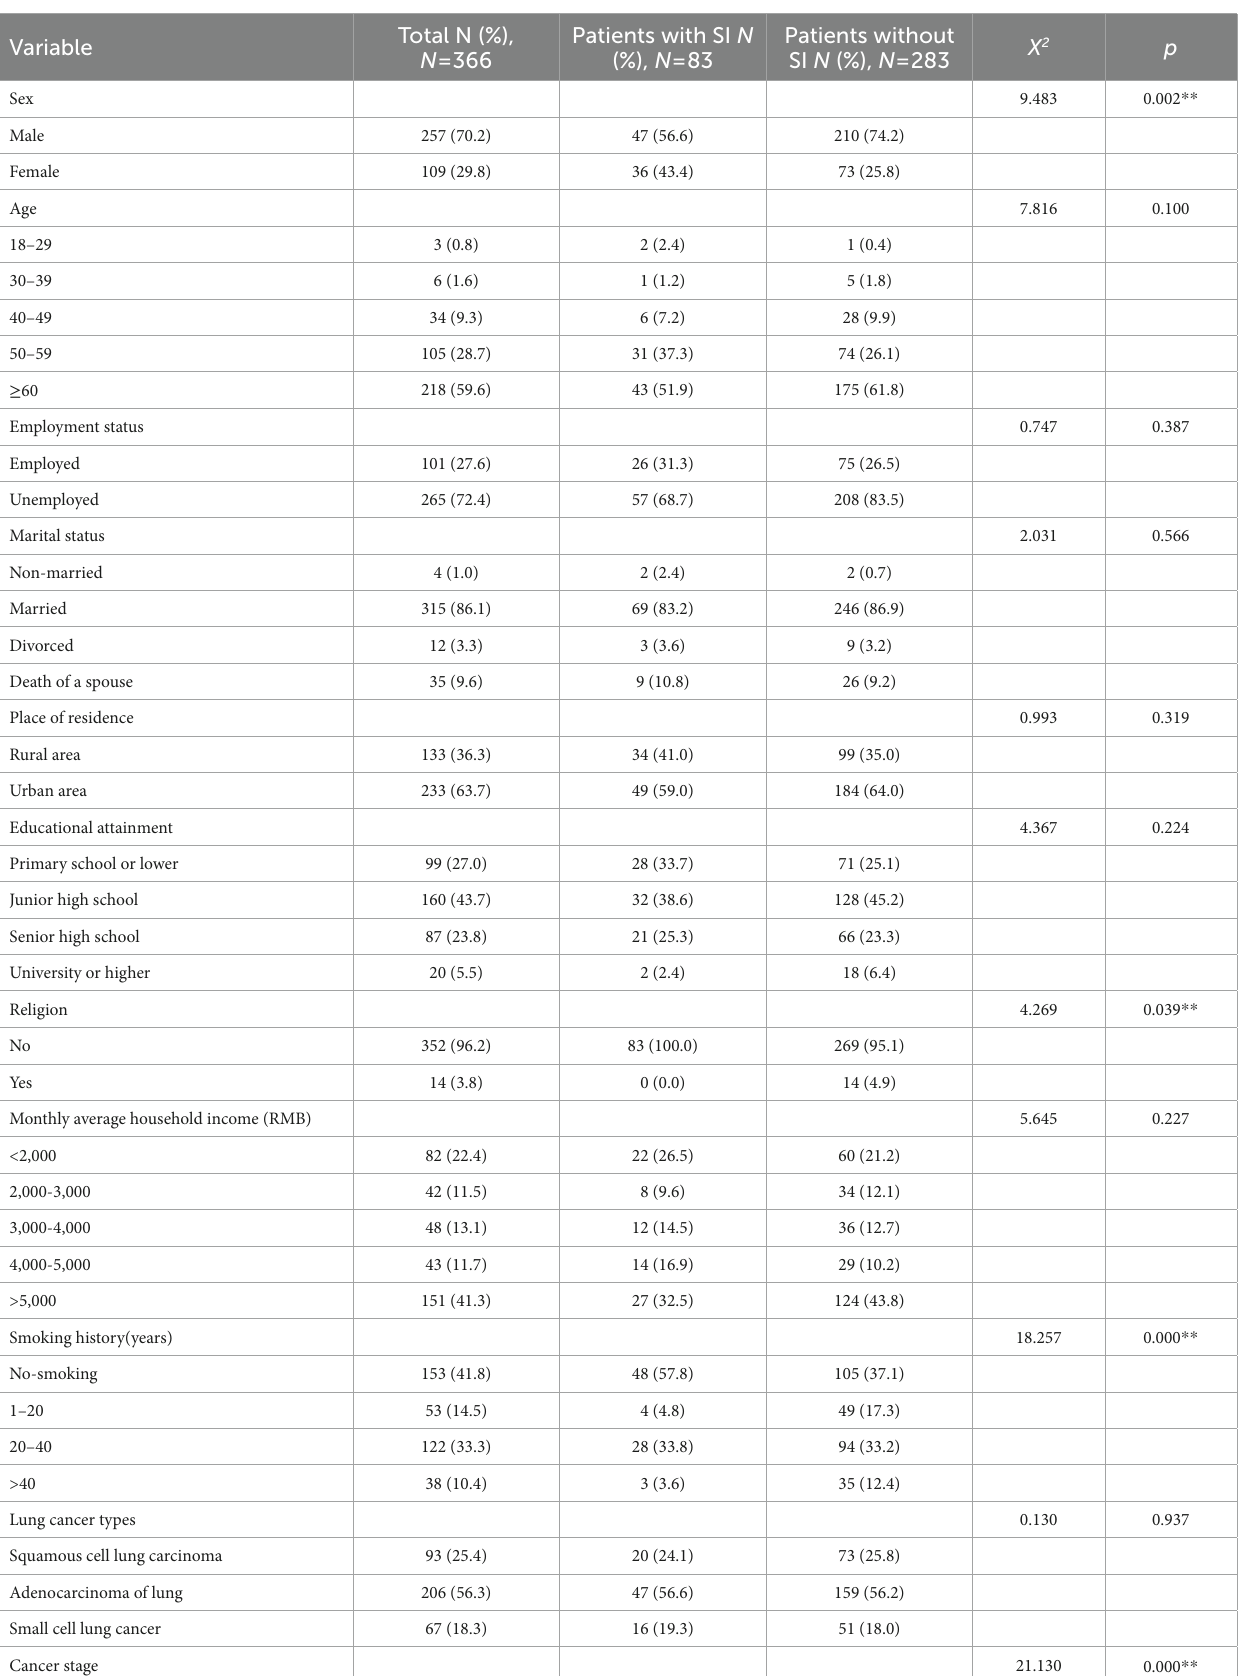
TABLE 2 Sociodemographic and clinical characteristics of lung cancer inpatients, with and without suicidal ideation. Variable